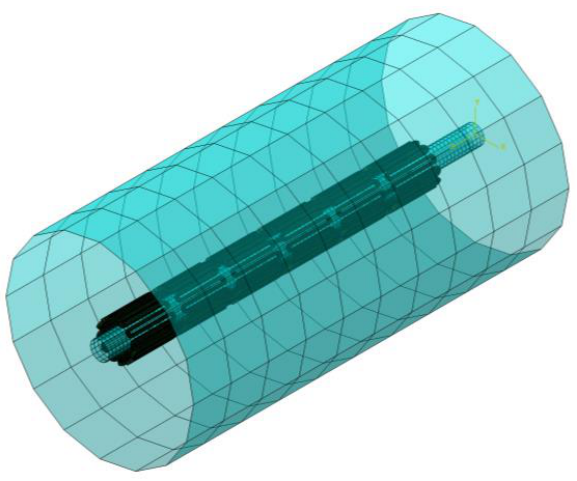
Figure 4. Assembly of finite element stent model with inner and outer cylinders.